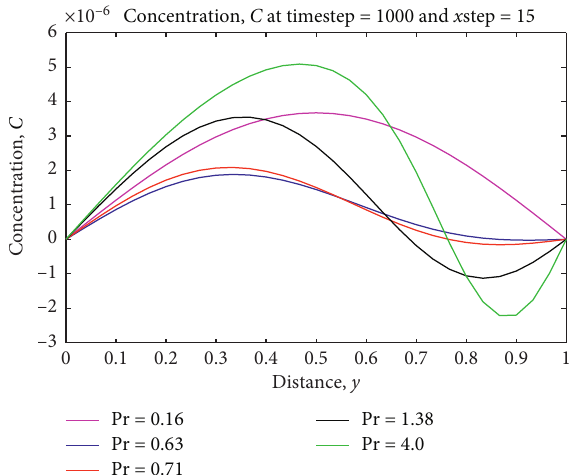
Figure 11: Effects of Prandtl number on concentration profile.